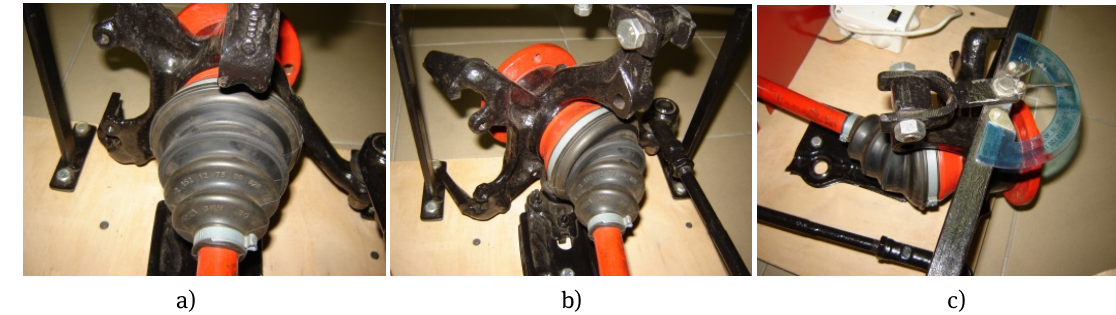
Figure 5: The stand view testing gaiter pivot drive for impact force: a) the centrifugal b) the compression, c) the tensile.